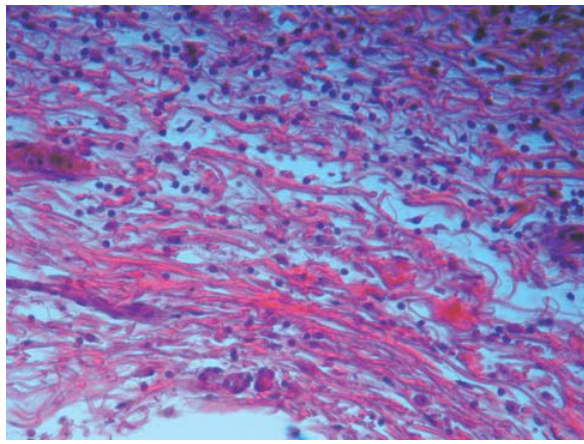
FIGURE 3- Demonstrative image of tissue reaction, considered severe, when using distilled water associated with calcium hydroxide at 7 days